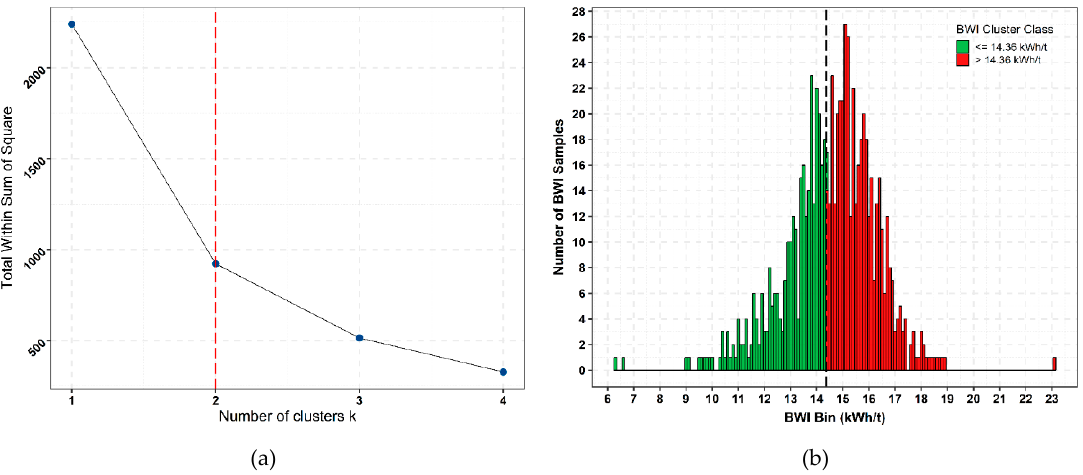
Figure 17. ( a ) Total within sum of square for K = 2,3 and 4 clusters of BWI sample data. Red line indicates the plot inflection at K = 2. ( b ) Histogram of BWI sample data with bins of 0.1 kWh/t. The BWI class boundary occurs at 14.36 kWh/t (dashed line).